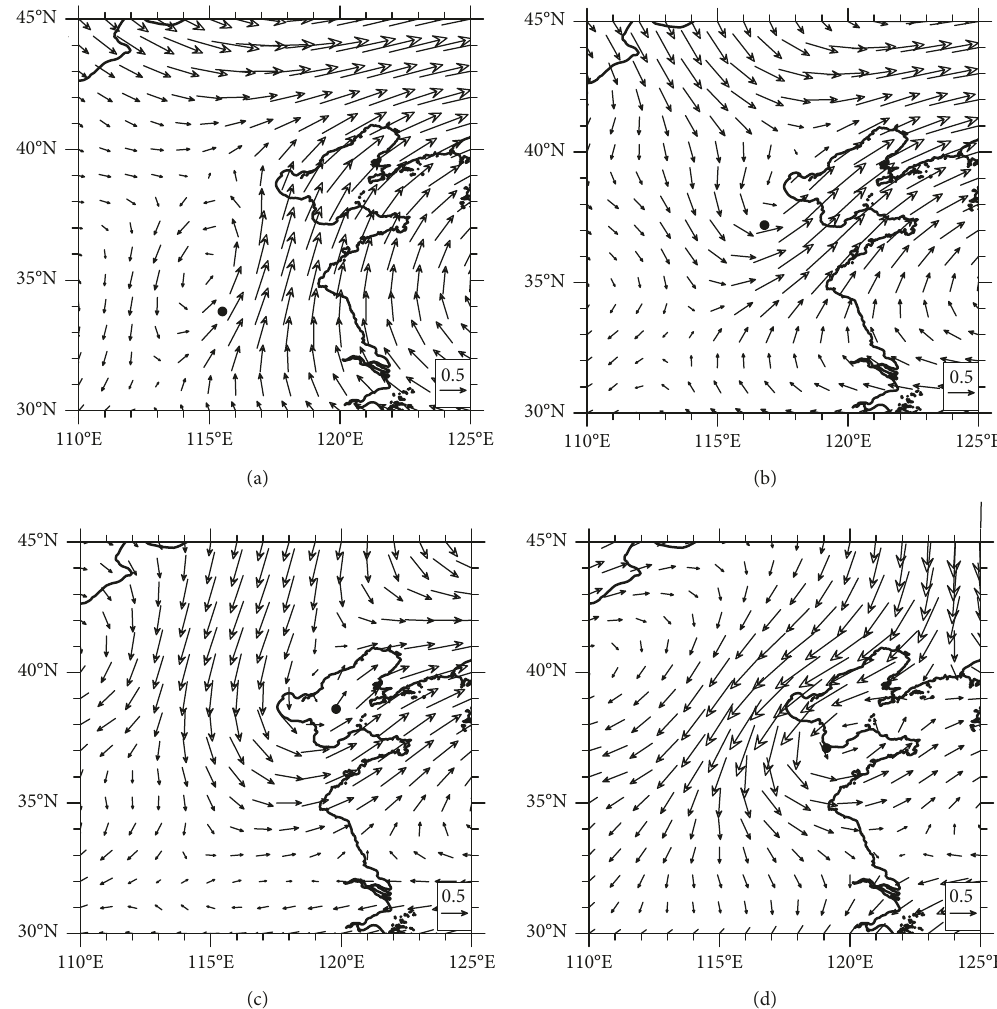
Figure 7: Steering flow ( × 10 2 m/s): (a) 0000 UTC 14 August; (b) 1200 UTC 14 August; (c) 0000 UTC 15 August; (d) 1200 UTC 15 August. The black dots represent the location of